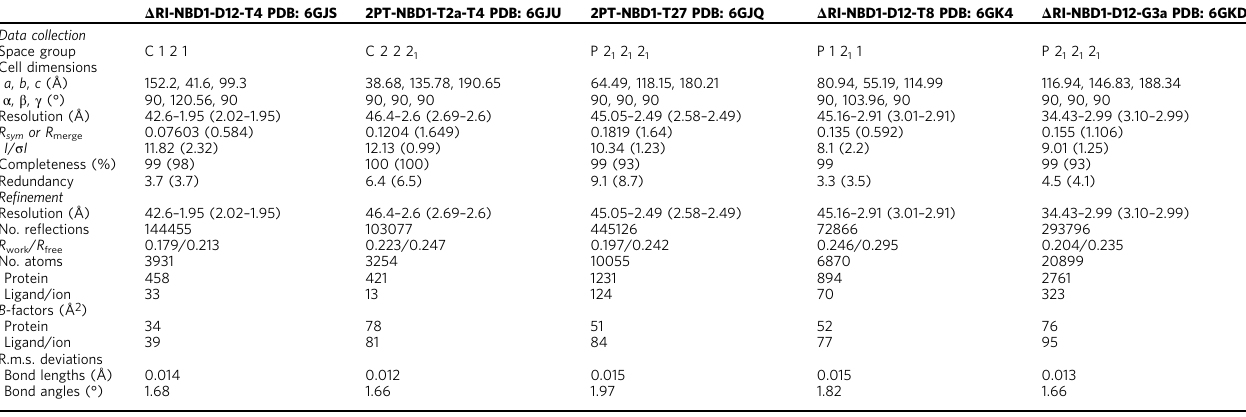
Table 1 Data collection and re fi nement statistics (molecular